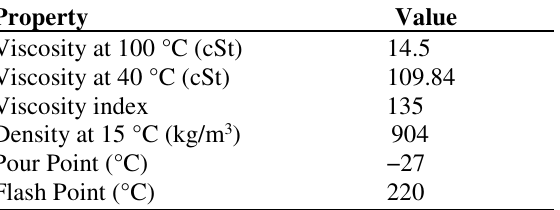
Properties of SAE 15W40 engine oil.